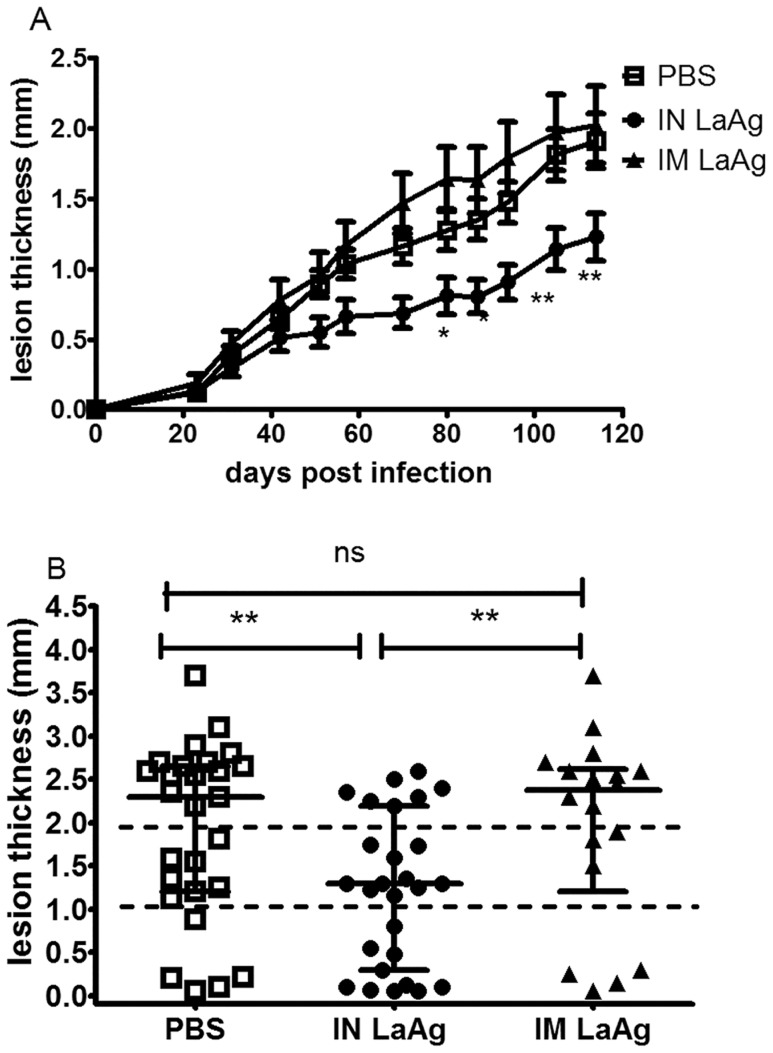
Effectiveness of intranasal (IN) and intramuscular (IM) L. amazonensis antigens (LaAg) vaccination against subsequent infection with L. braziliensis.
Golden hamsters (6–8 per group) were vaccinated with either 10 µg of LaAg intranasally (•) or 20 µg of LaAg intramuscularly (▴) followed by a booster vaccination 14 days later. Controls received PBS (□). Two weeks after the booster vaccination, animals were infected in the paw with 1×105
L. braziliensis. (A) Lesion thickness was scored on the indicated days. Means ± standard errors of the means (SEM), * p≤0.05, ** p≤0.01. (B) On day 114 post-infection, the lesion thickness of individual feet was shown as individual values, with the horizontal bars representing the median values. Data are from four independent experiments.